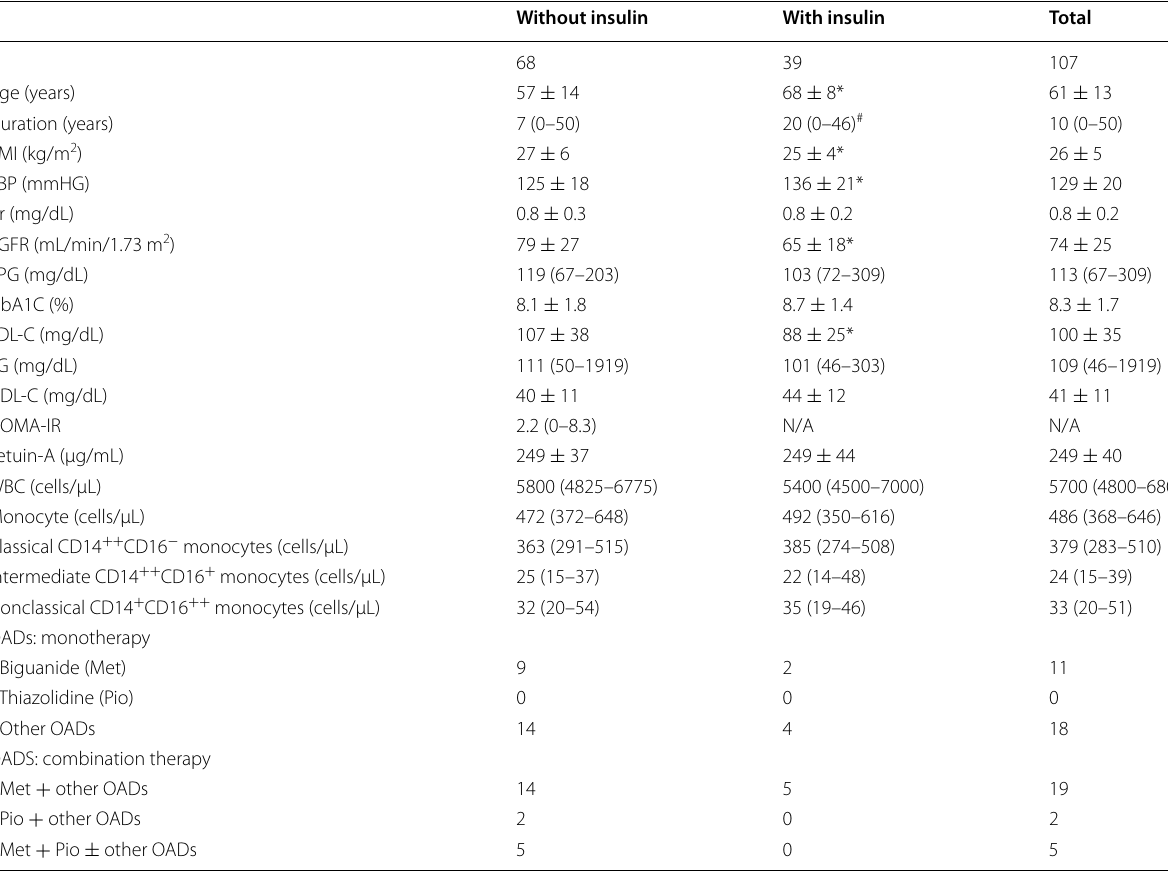
Data are presented as mean standard deviation, number, or median (interquartile range) ± SBP systolic blood pressure, Cr creatinine, LDL-C low-density lipoprotein-cholesterol, TG triglyceride, HDL-C high-density lipoprotein-cholesterol, WBC white blood cells, OADs Oral antidiabetic drugs, Met metformin, Pio pioglitazone *, # P < 0.05 versus group without